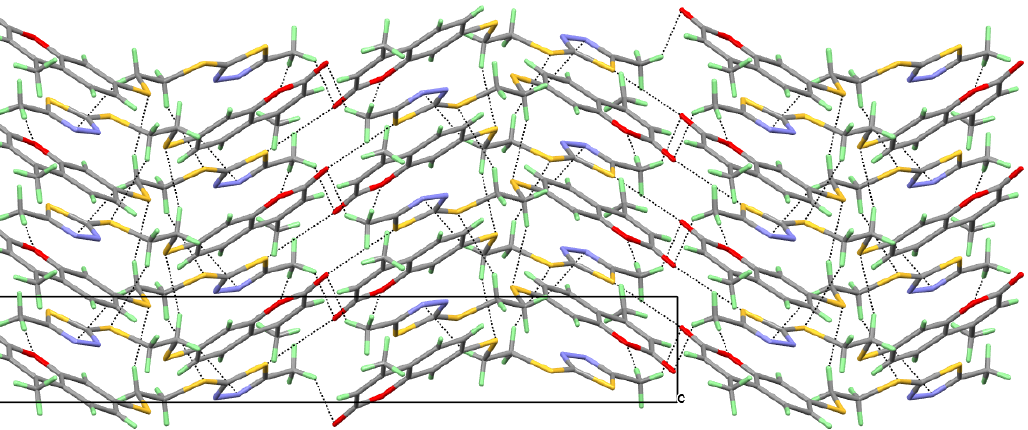
Figure 3. Observed weak C-H 3 . . . O, C-H 2 , and S . . . O=C interactions, stabilizing the crystal packing in 3